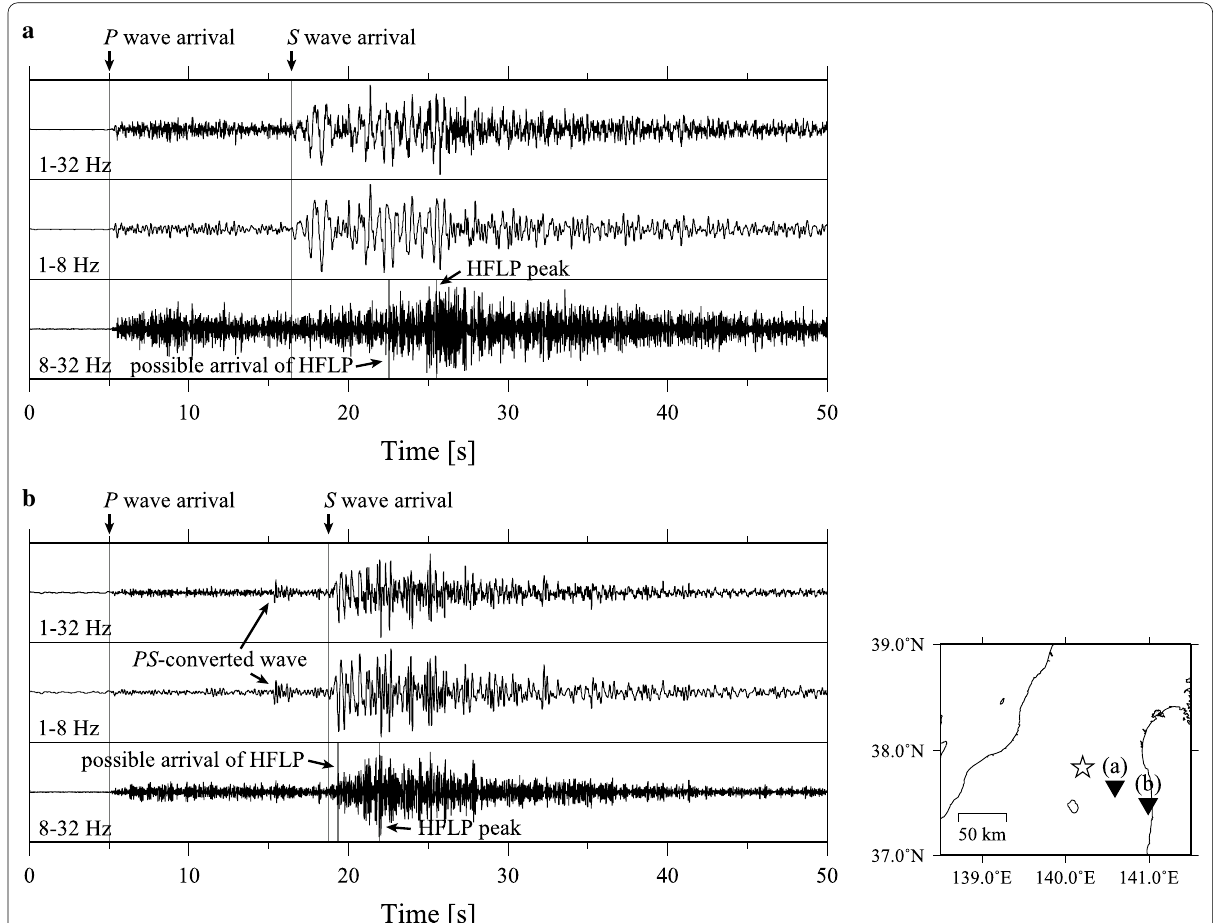
Fig. 2 East–west bandpass-filtered seismograms of an intraslab earthquake. Frequency ranges are 1–32 Hz (top), 1–8 Hz (center), and 8–32 Hz (bottom). The white star and black inverted triangles in the inset map denote the earthquake that occurred at a depth of 112 km and the station locations,